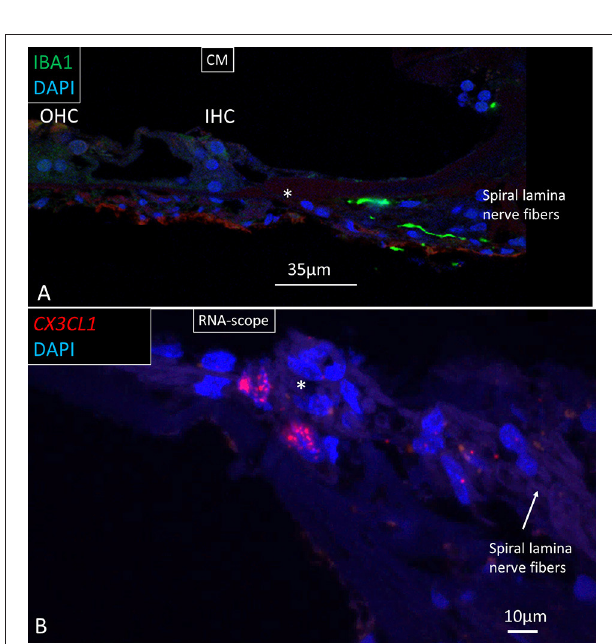
FIGURE 11 | (A) Confocal image of IBA1 macrophages running along lamina nerve fibers. *HP. (B) SR-SIM and RNA-scope of fractalkine gene expression in cells surrounding the unmyelinated lamina fibers. IHC, inner hair cell; OHC, outer hair cell; CM; confocal